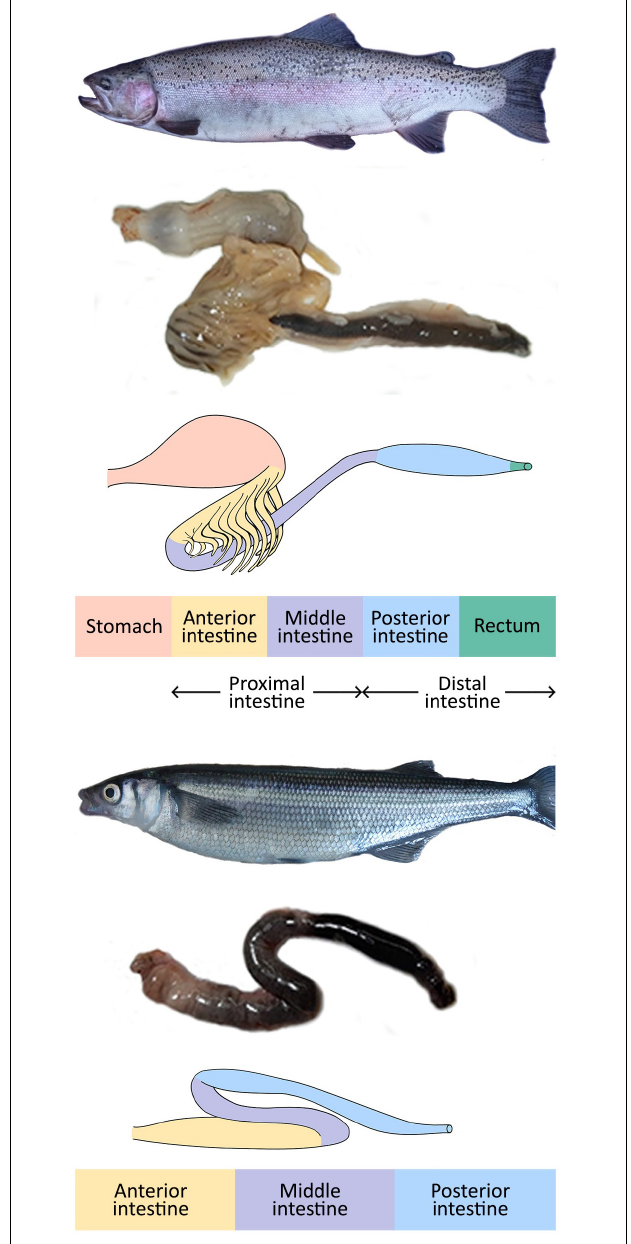
FIGURE 1 | Rainbow trout ( Oncorhynchus mykiss ) and Patagonian silverside ( Odontesthes hatcheri ) (top and bottom, respectively) with a detail of their gastrointestinal